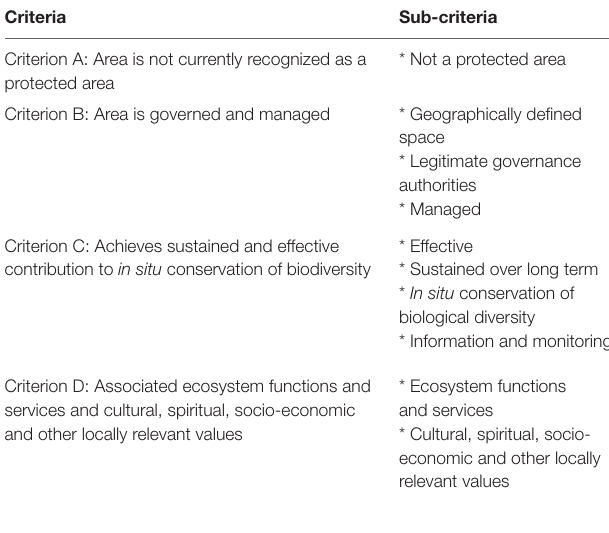
TABLE 1 | Criteria included in Section B of Annex III to Decision 14/8 relevant for the identification of